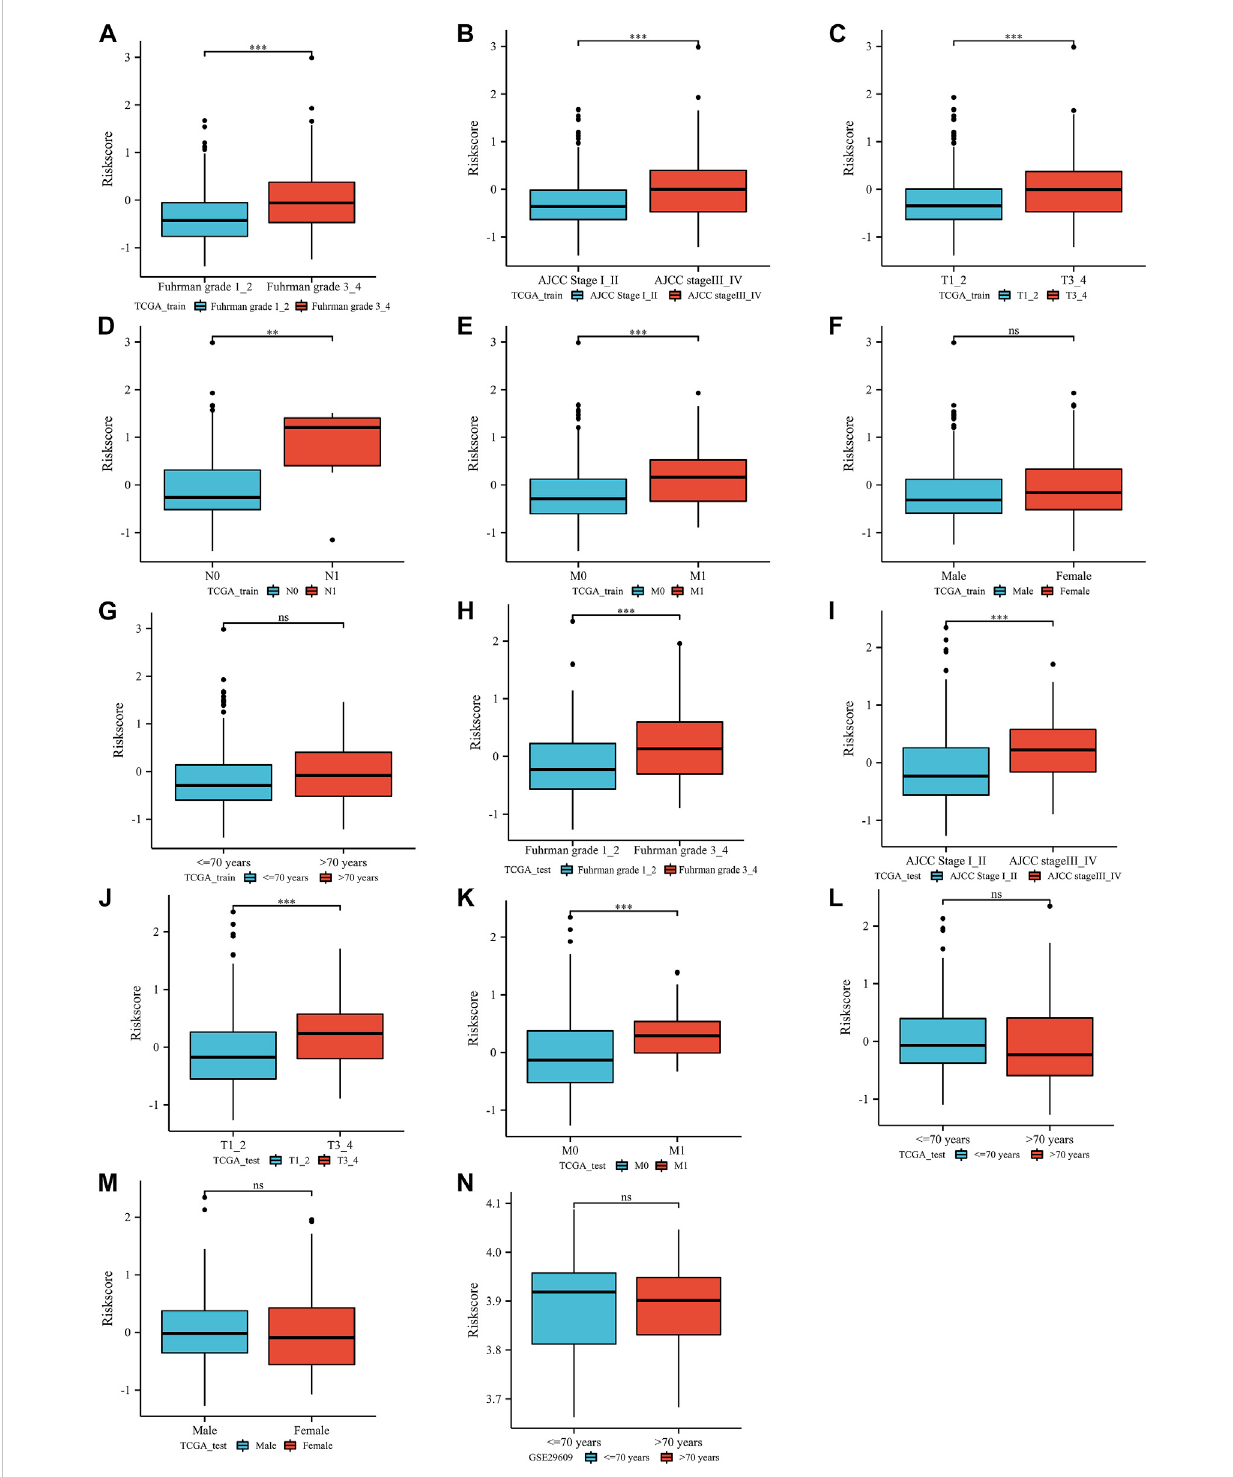
FIGURE 3 The correlation between the index and clinical parameters: TCGA training group (Furhman grade (A) , AJCC stage (B) , T stage (C) , lymph node metastasisstage (D) ,distantmetastasisstage (E) ,sex (F) ,age (G) ),TCGAtestgroup(Furhmangrade (H) ,AJCCstage (I) ,Tstage (J) ,distantmetastasisstage (K) , age (L) , sex (M) ), GSE29609 dataset (age (N) ). N: lymph node metastasis; M: distant metastasis; AJCC: American Joint Committee on Cancer; ns, p ≥ 0.05; *, p < 0.05; **, p < 0.01; ***, p <